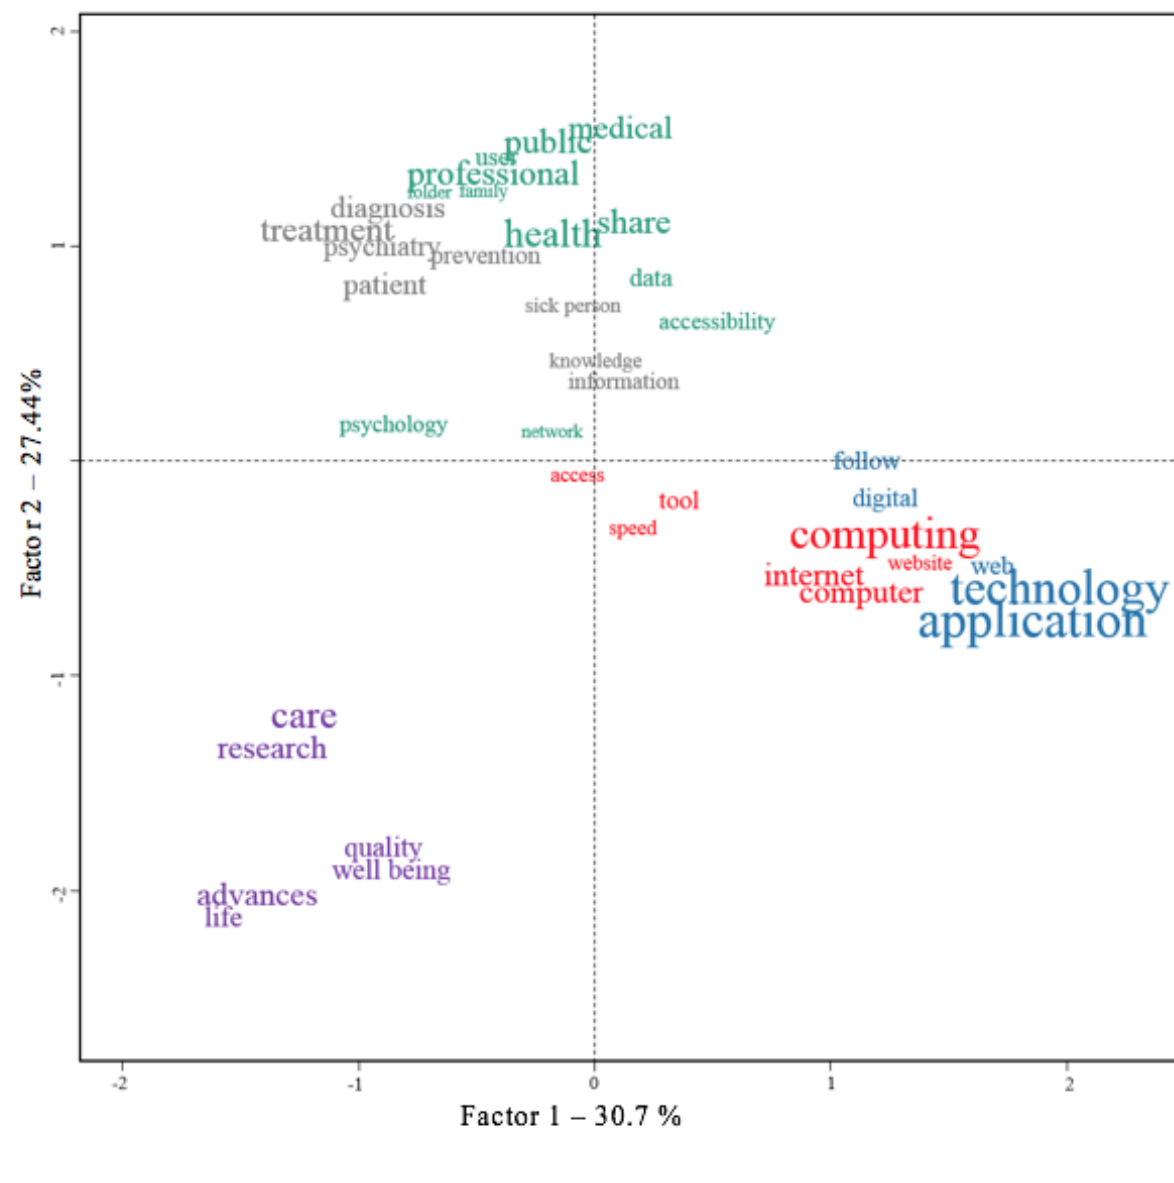
Figure 2. Correspondence factor analysis of the free-word association about e-mental